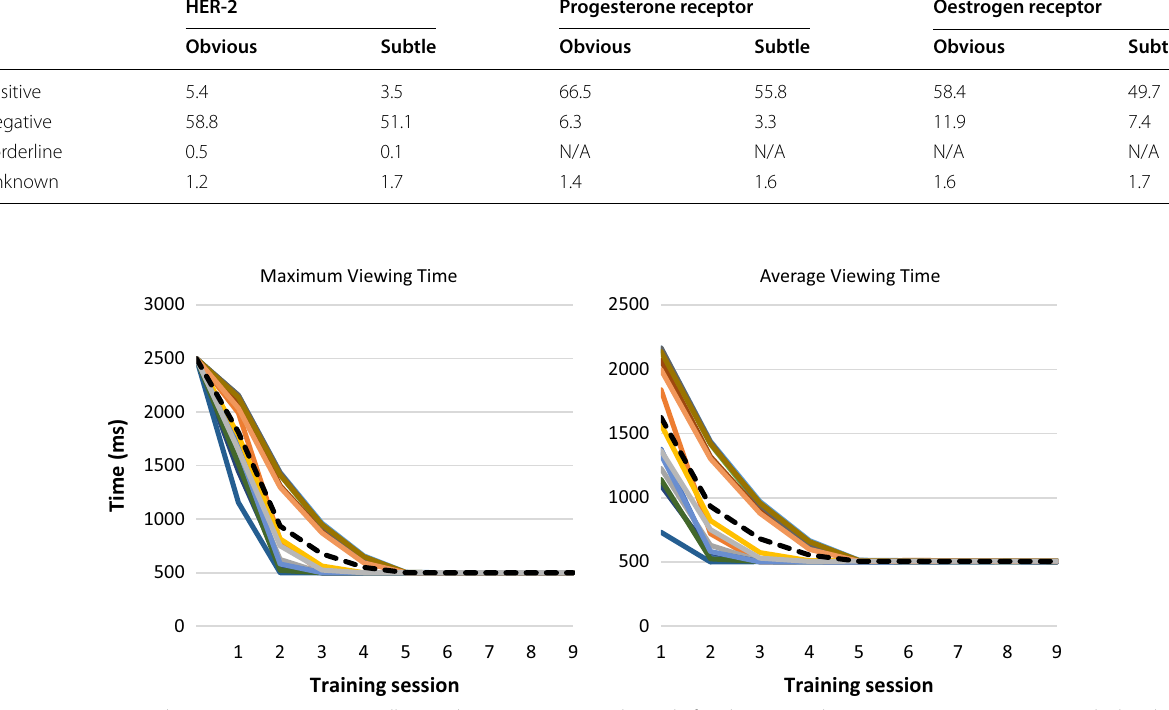
Fig. 7 Maximum and average viewing time in milliseconds per participant at the end of each training phase. Maximum viewing time is calculated for the fourth block of the session. Individual lines are plotted, while the dashed black line represents the group